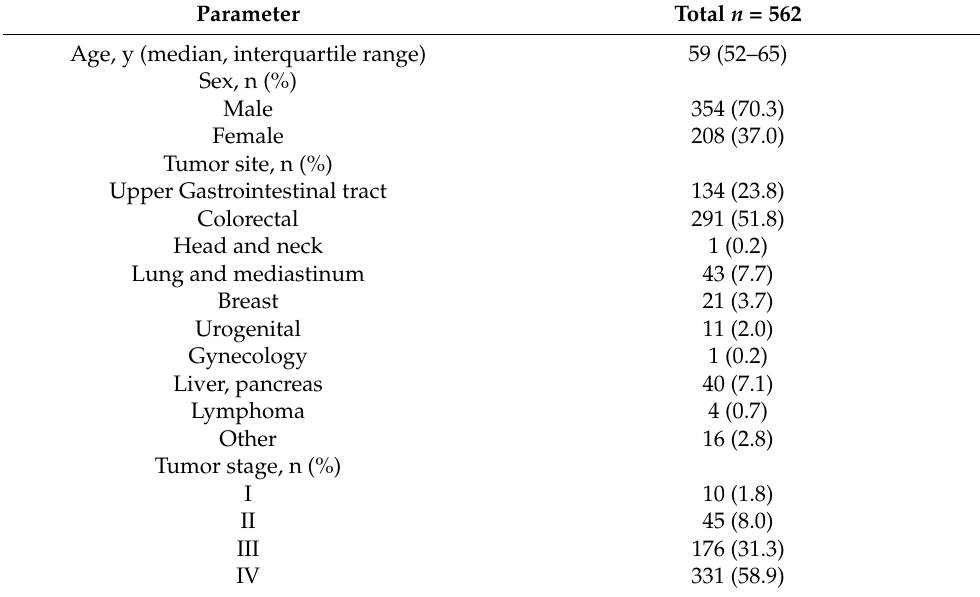
Table 1. Characteristics of 562 patients with cancer enrolled in this study.